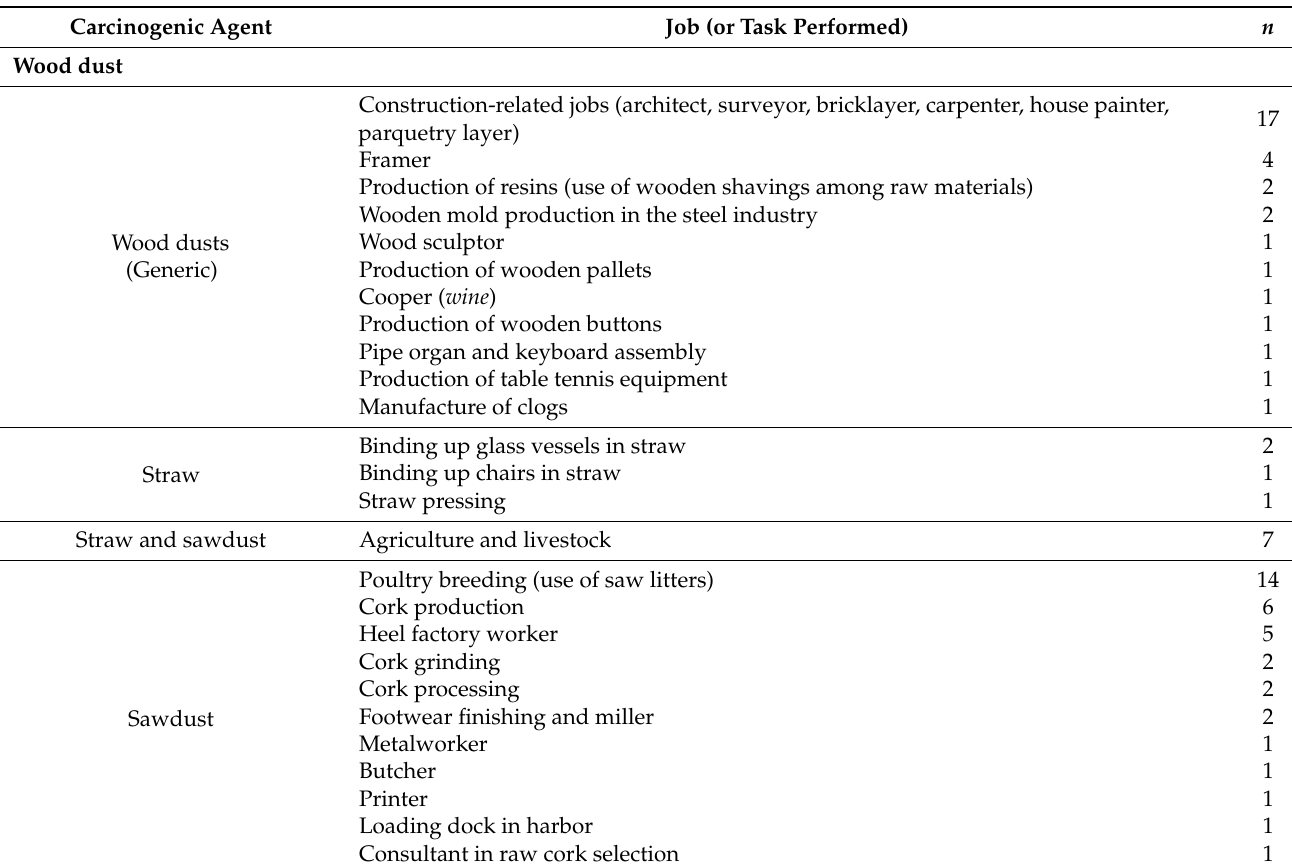
Table 2. Occurrences ( n ) of exposure (or tasks) to an IARC carcinogenic agent in jobs for the nasal cavity and paranasal sinuses in atypical working situations assessed by industrial hygienists of each COR. Carcinogenic Agent Job (or Task Performed) n Wood